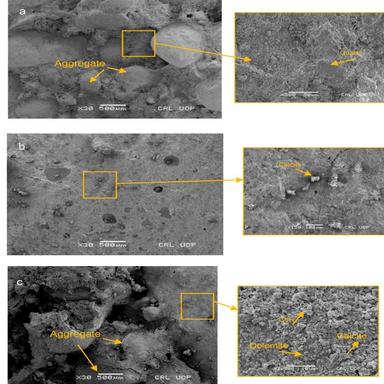
SEM Micrographs of Mortar Samples: a) M5; b) M6; c) M8.